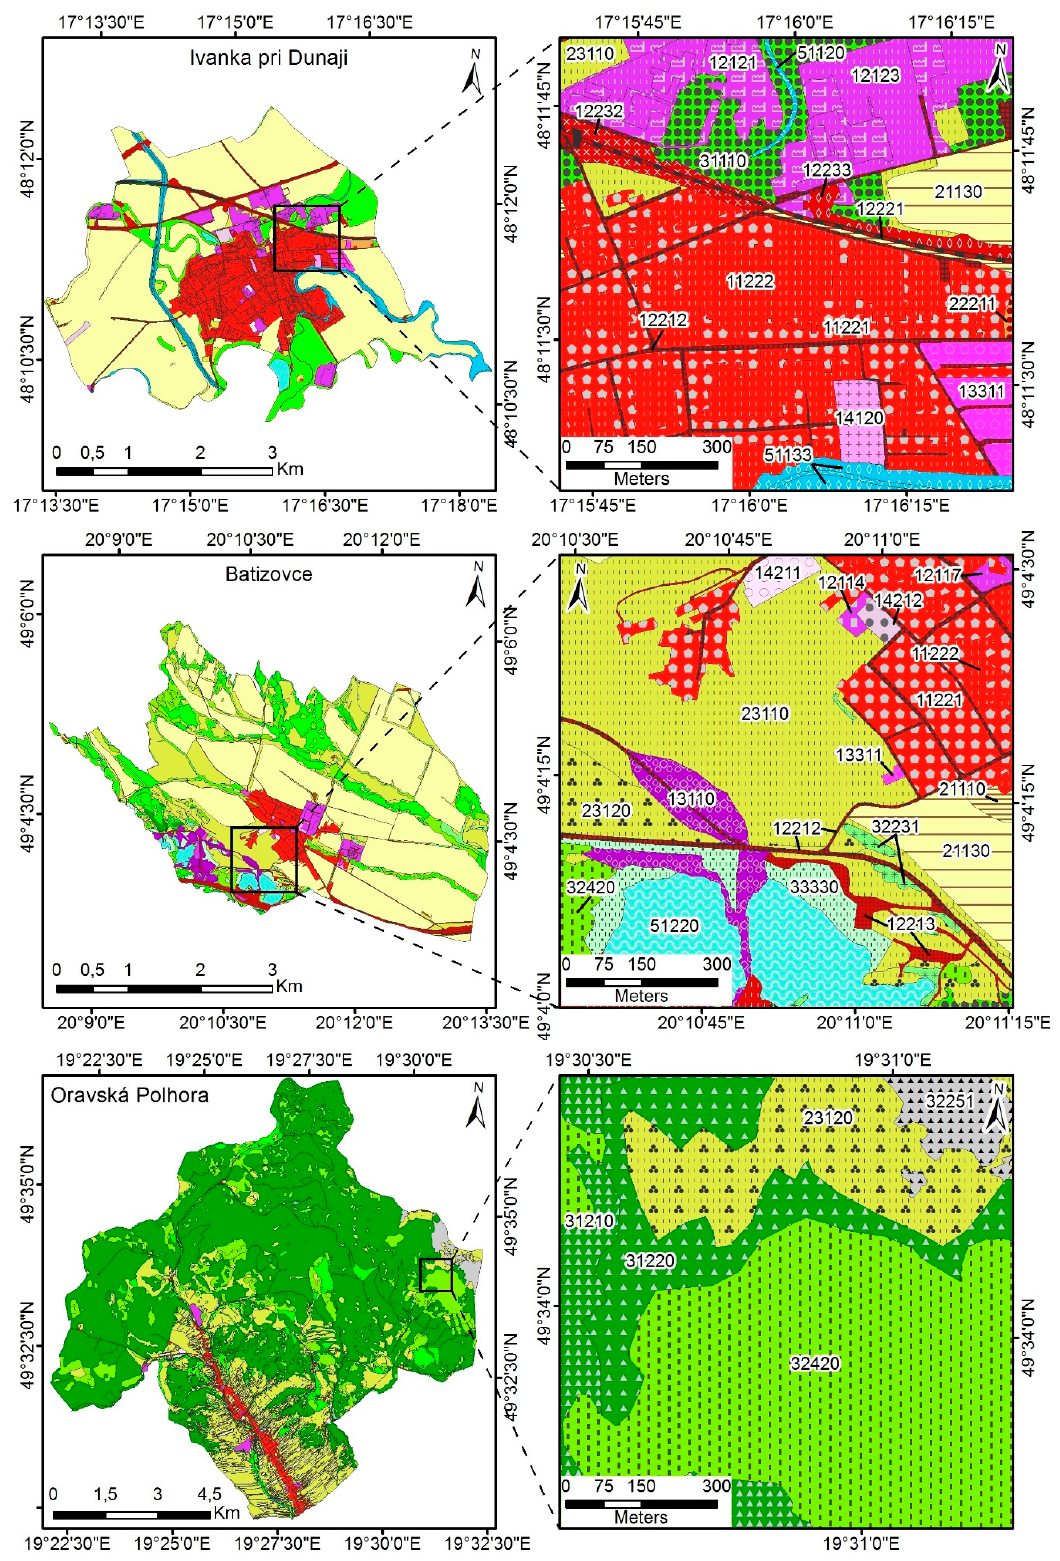
Figure 5. Case studies with the CLC5 maps in 2018 ( left ) and examples of the detail outputs of this mapping at a scale of 1:10,000 ( right ). The colours correspond to the legend in Figure 1 (see above).